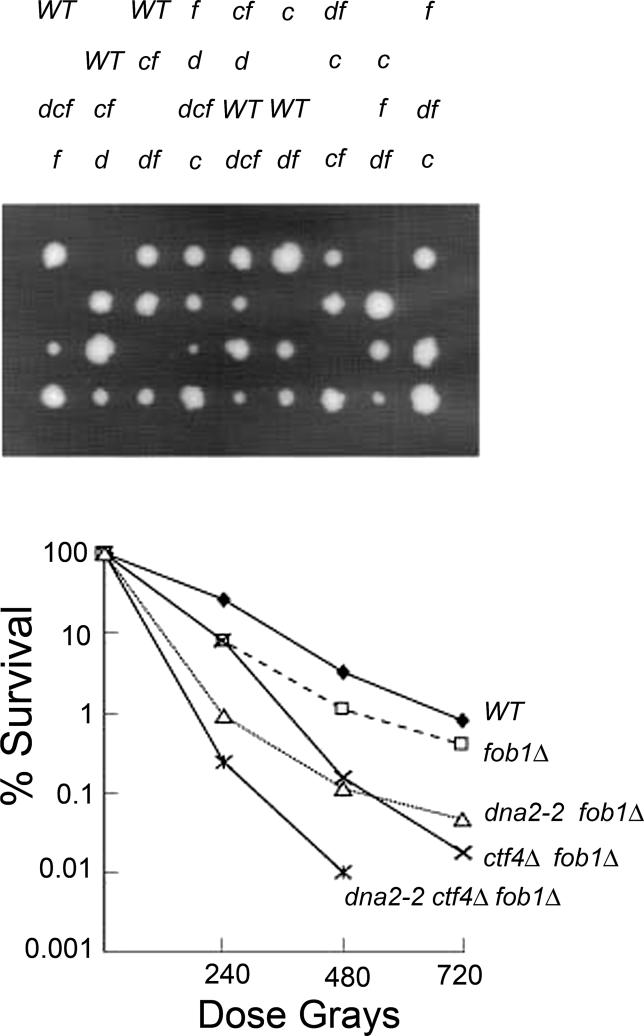
Deletion of FOB1 Suppresses dna2 ctf4Δ Synthetic LethalityTop panel: Tetrads from the dissection of a DNA2/dna2–2 CTF4/ctf4Δ FOB1/fob1Δ heterozygote. c, ctf4Δ; d, dna2Δ; f, fob1Δ; WT, DNA2 CTF4 FOB1. The following spores were recovered: 11 WT, 21 dna2–2, 26 fob1Δ, 17 ctf4Δ, 18 dna2–2 fob1Δ, 20 ctf4Δ fob1Δ, zero ctf4Δ dna2–2, and six dna2–2 ctf4Δ fob1Δ. Since the triple mutant grew slowly at 30 °C, another 27 spores were dissected and incubated at 23 °C. The following spores were recovered: 14 WT, nine fob1Δ, 14 ctf4Δ, seven dna2–2, 14 dna2–2 fob1Δ, nine ctf4Δ fob1Δ, zero dna2–2 ctf4Δ, and nine dna2–2 ctf4Δ fob1Δ. The triple mutant did not grow at 37 °C.Bottom panel: X-ray sensitivity of dna2–2 ctf4Δ fob1Δ. Strains with genotype WT, fob1Δ, dna2–2 fob1Δ, ctf4Δ fob1Δ, and dna2–2 ctf4Δ fob1Δ were grown to log phase, irradiated as described in Materials and Methods, serially diluted, plated on YPD plates, and incubated at 30 °C. Strains are isogenic or congenic with 4741.